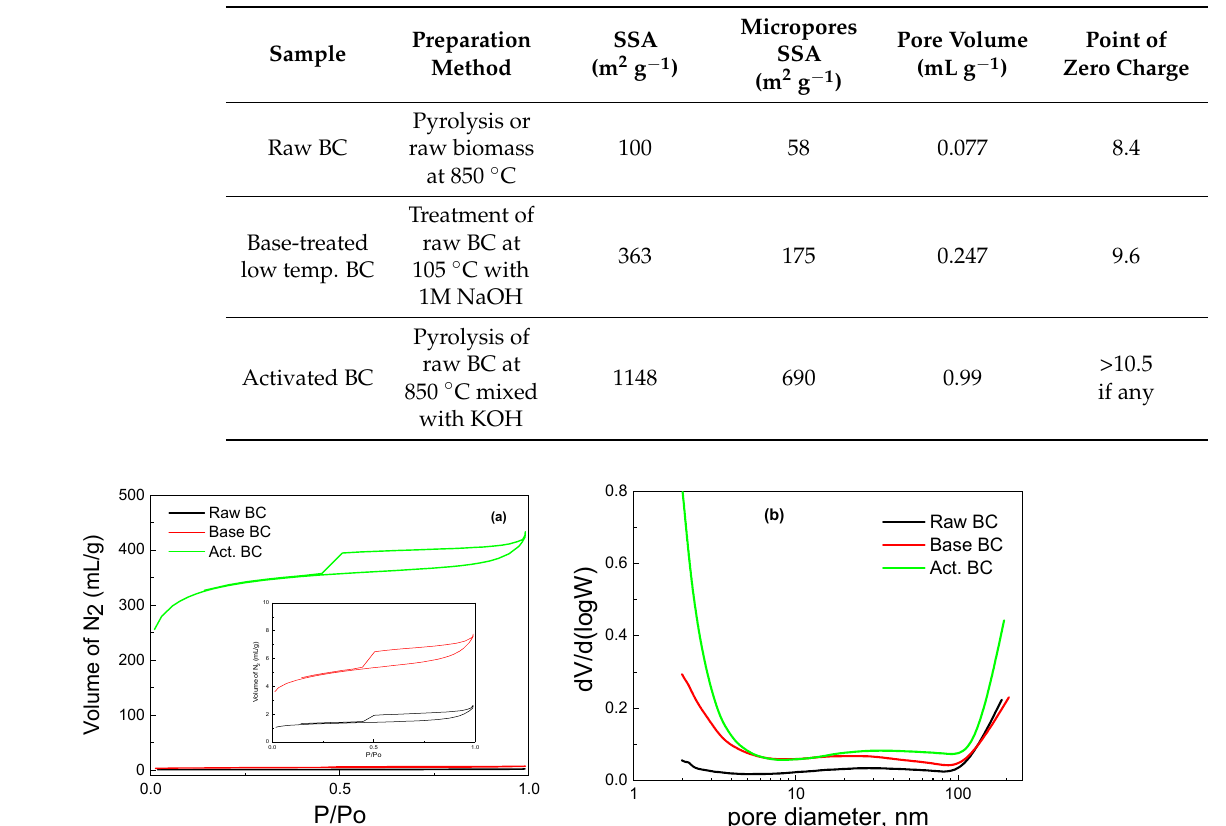
Table 1. Characterization data of the employed biochar.